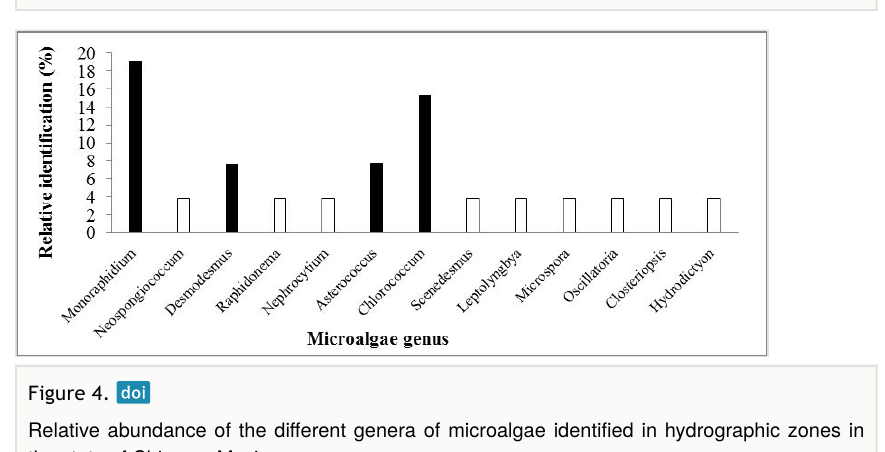
Figure 3. Microalgae identi fi ed in the di ff erent hydrographic zones of the state of Chiapas using a FlowCam coupled to a microscope (100x). Suchiate river : a) Monoraphidium contortum ; b) Neospongiococcum gelatinosum ; c) Desmodesmus serratus ; Nandayapa river : d) Raphidonema nivale ; e) Nephrocytium lunatum ; Huixtla river : f) Asterococcus superbus ; g) Chlorococcum echinozygotum ; Spring water Cahuaré : h) Monoraphidium contortum ; i) Scenedesmus quadricauda ; j) Monoraphidium gri ffi thii ; Novillero river : k) Chlorococcum echinozygotum ; l) Leptolyngbya sp.; m) Microspora fl occosa ; Wastewaters "La chacona ": n) Asterococcus superbus ; Pijijiapan river : ñ) Chlorococcum echinozygotum ; Santo Domingo river : o) Oscillatoria brevis ; p) Monoraphidium contortum ; q) Chlorococcum echinozygotum ; r) Desmodesmus serratus ; s) Closteriopsis acicularis ; t) Hydrodictyon reticulatum .